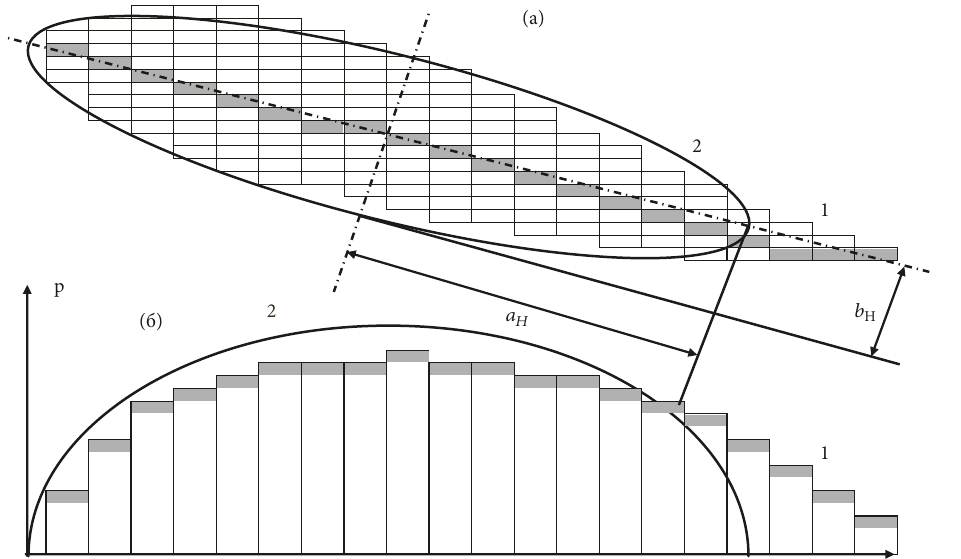
Figure 4: Contactarea (a)and pressuredistribution (b)in Novikov’scylindricalgear: 1: contactof real surfaces;2:equivalentelliptical contact.